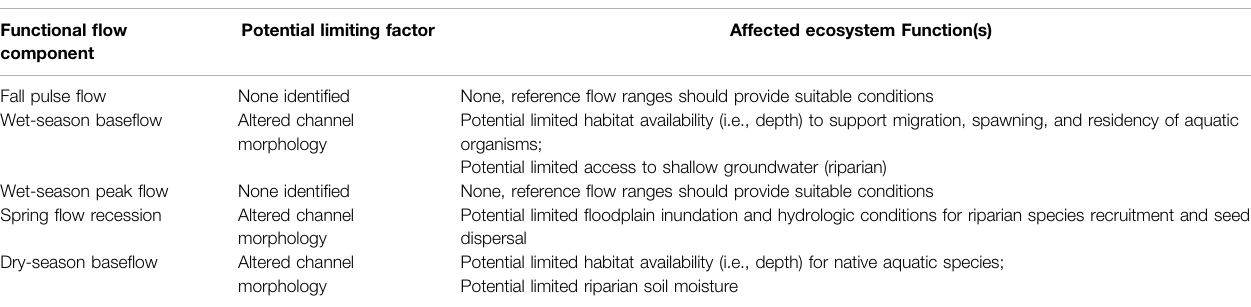
TABLE 4 | Potential non- fl ow limiting factors that may alter the relationship between the natural range of functional fl ow metrics and their intended functions for each functional fl ow component. Functional fl ow